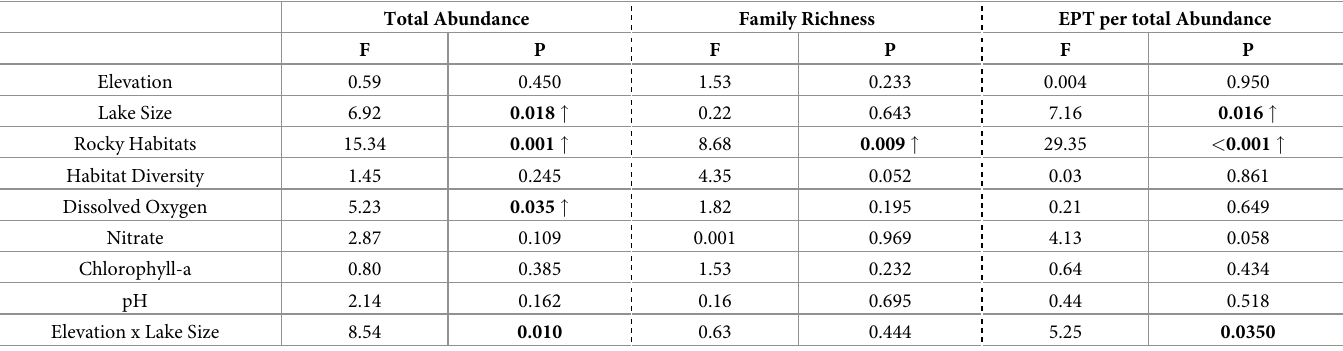
Table 1. Results of generalized linear modelling (GLM), applying quasipoisson distribution and a log link for total abundance (D 2 = 0.719), family richness (D 2 = 0.544) and the ratio of Ephemeroptera, Plecoptera, Trichoptera (EPT) abundance to total abundance (D 2 = 0.712) of macroinvertebrates in alpine lakes of Hohe Tauern National Park